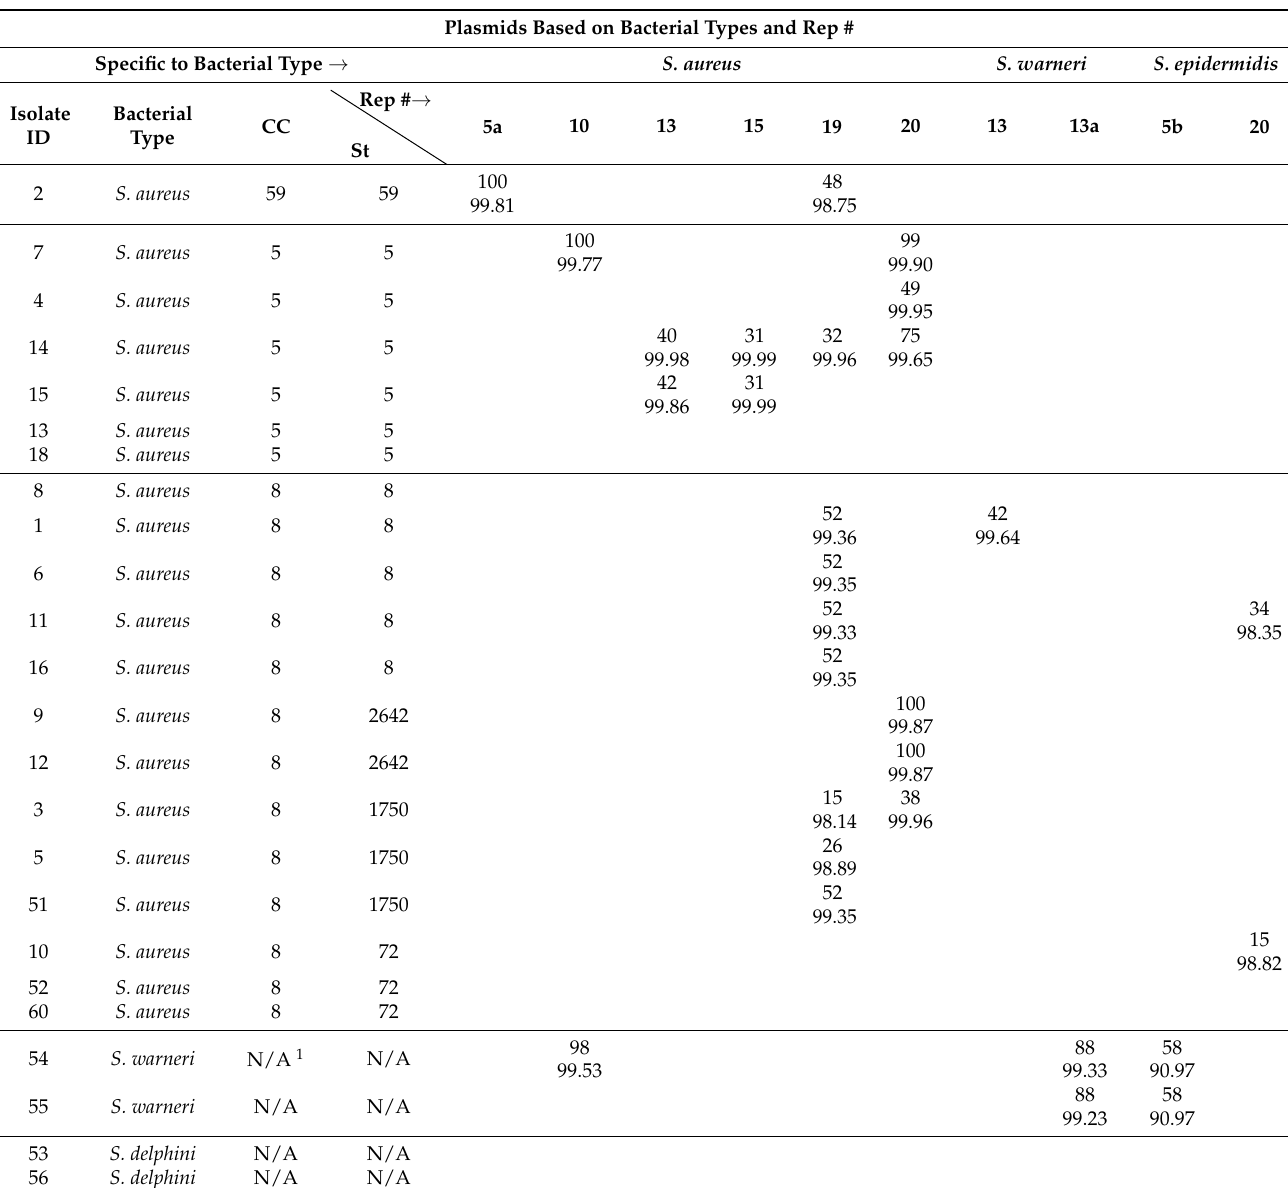
Table 3. Plasmid in each staphylococci isolate with percent of query coverage (top value) and percent identify (bottom value). Plasmids Based on Bacterial Types and Rep # Specific to Bacterial Type